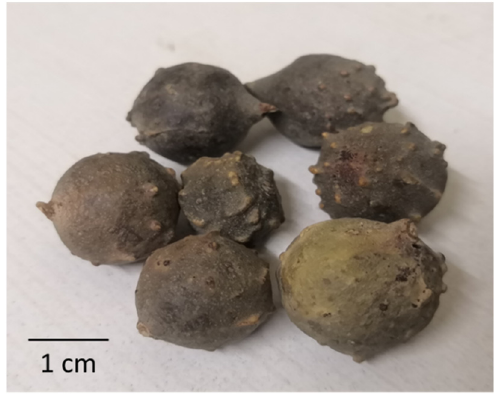
Figure 1. The galls of Quercus infectoria (QI) used in this study. Gallotannin is found as the major constituent (50–70%) in QI galls, present along with gallic acid (2–4%) and a small amount of free ellagic acid, starch and sugar [11]. Being the broadest phytochemical present in QI galls, gallotannin is strongly related to the biological effects induced by the QI galls, as reported previously [12,13]. Nonetheless, to date, there is still no study to report and validate the therapeutic potential of gallotannin extracted from the QI galls to treat the stage IV human brain tumor, GBM. Therefore, in this study, we aimed to extract the gallotannin from QI galls using a novel extraction procedure to determine its efficiency to treat